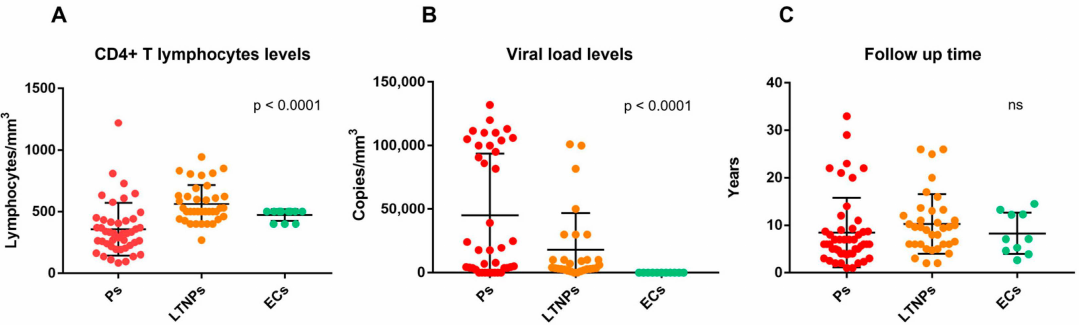
Figure 1. CD4+ T lymphocytes levels ( A ), viral load levels ( B ), and follow up time ( C ) in progressors (Ps), long-term non-progressors (LTNPs), and elite controllers (ECs). p -values computed through the Kruskal–Wallis